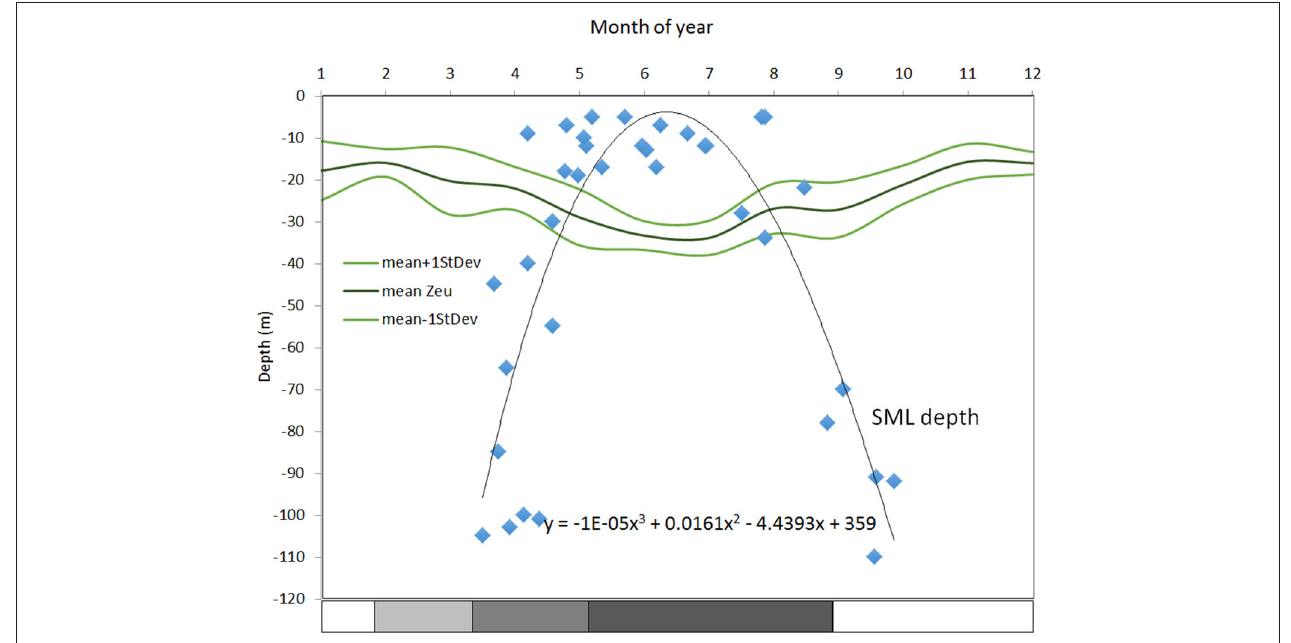
FIGURE 4 | Climatologies for the euphotic zone and thermal-surface mixed layer (th-SML) for the WIS in m. Surface mixed layer depth (m) from Gowen et al. (1995), defined as the depth at which temperature was 0.5 ◦ C less than that at 2m over-plotted with the euphotic zone depth (Z eu ) (defined as that of 1% surface PAR) calculated from k D for 2002–2012 from remote sensing (see Capuzzo et al., 2013 and references therein). The stratification bar indicates the salinity and temperature contribution to the overall